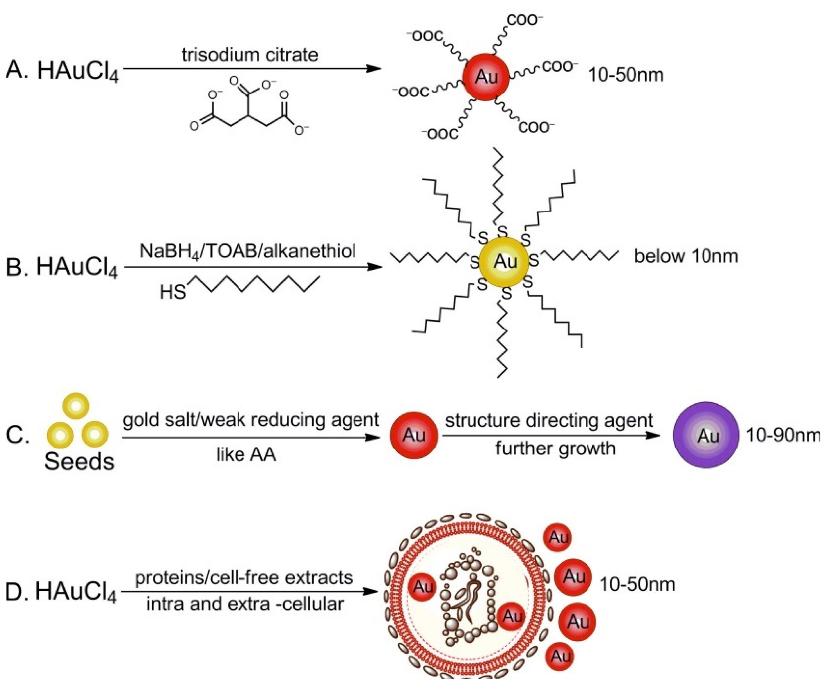
Figure 2. ( A ) Turkevich–Frens method for synthesis of AuNPs via reduction of gold salts in the presence of trisodium citrate; ( B ) Brust–Schiffrin strategy for two-phase fabrication of small-size AuNPs via reduction of gold salts in the presence of thiol ligands; ( C ) seed-mediated growth method for AuNPs; ( D ) green synthesis of non-toxic AuNPs through intra- and extra-cellular biosynthesis in the presence of proteins or cell-free extracts. Reprinted with permission from [40] Copyright 2018 Elsevier.